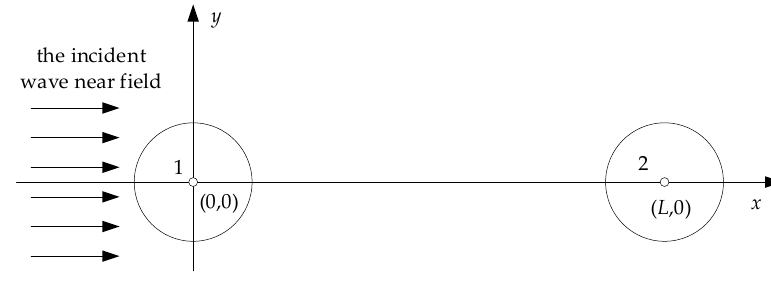
Figure 7. A schematic of the array position.